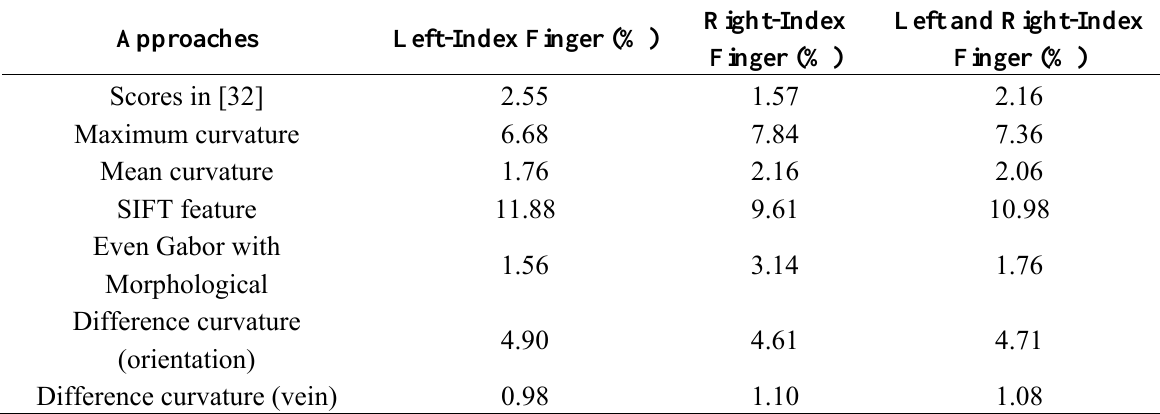
Table 2. Performance from finger-vein matching with various approaches (Database